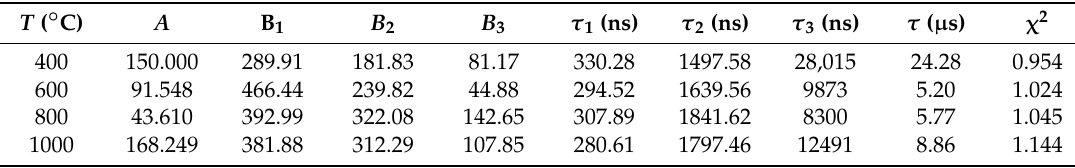
Figure 19. Time-resolved PL spectra of Eu-doped ZnWO 4 precursors subjected to annealing at different temperatures: ( a ) 400 °C; ( b ) 600 °C; ( c ) 800 °C; and ( d ) 1000 °C. The detection wavelength is fixed at 612 nm. The repetition frequency of the pulsed laser diode is 20 kHz. Table 4. Fitting parameters of the time-resolved PL spectra of Eu-doped ZnWO 4 precursors subjected to annealing at different temperatures. The detection wavelength is 612 nm.